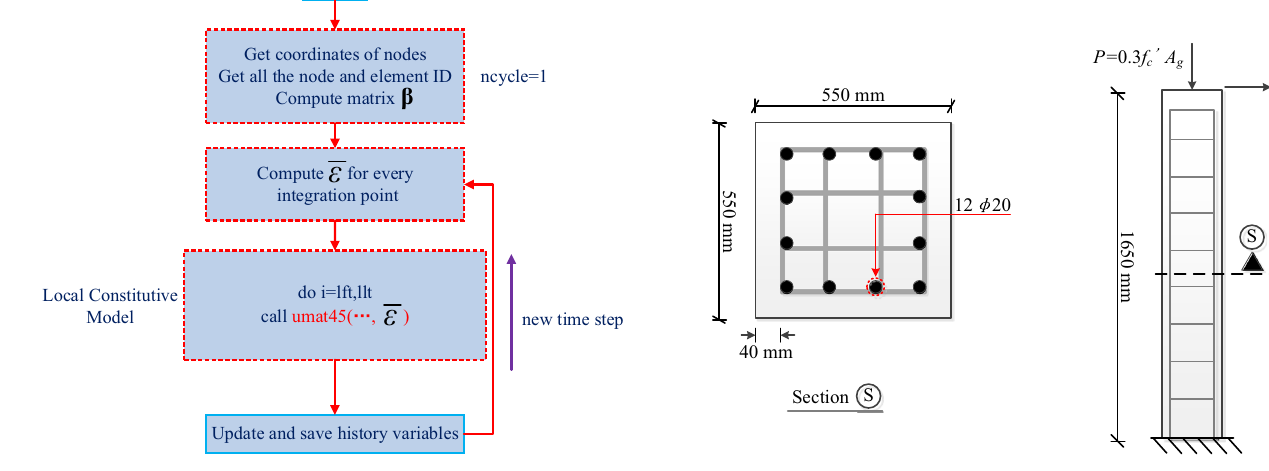
Fig. 12 Numerical procedure of the nonlocal formulation. Fig. 13 Configuration of the tested RC